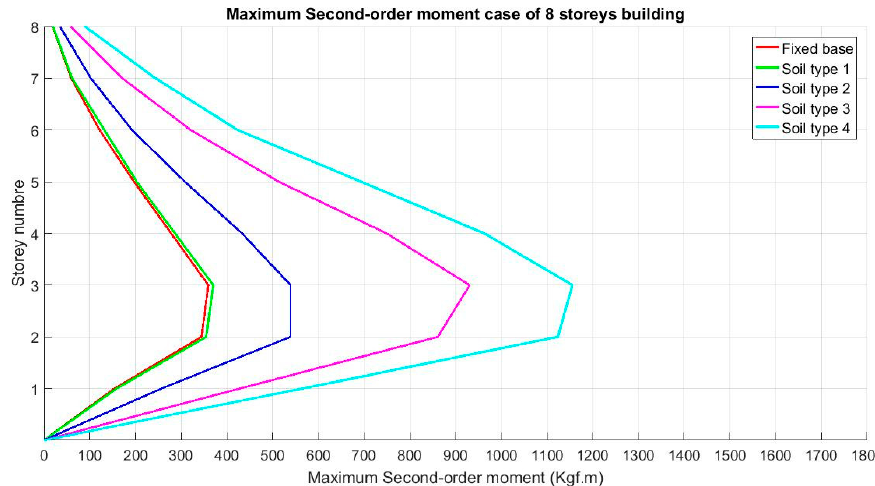
Figure 11. Maximum second-order moment case of a 5-story building .